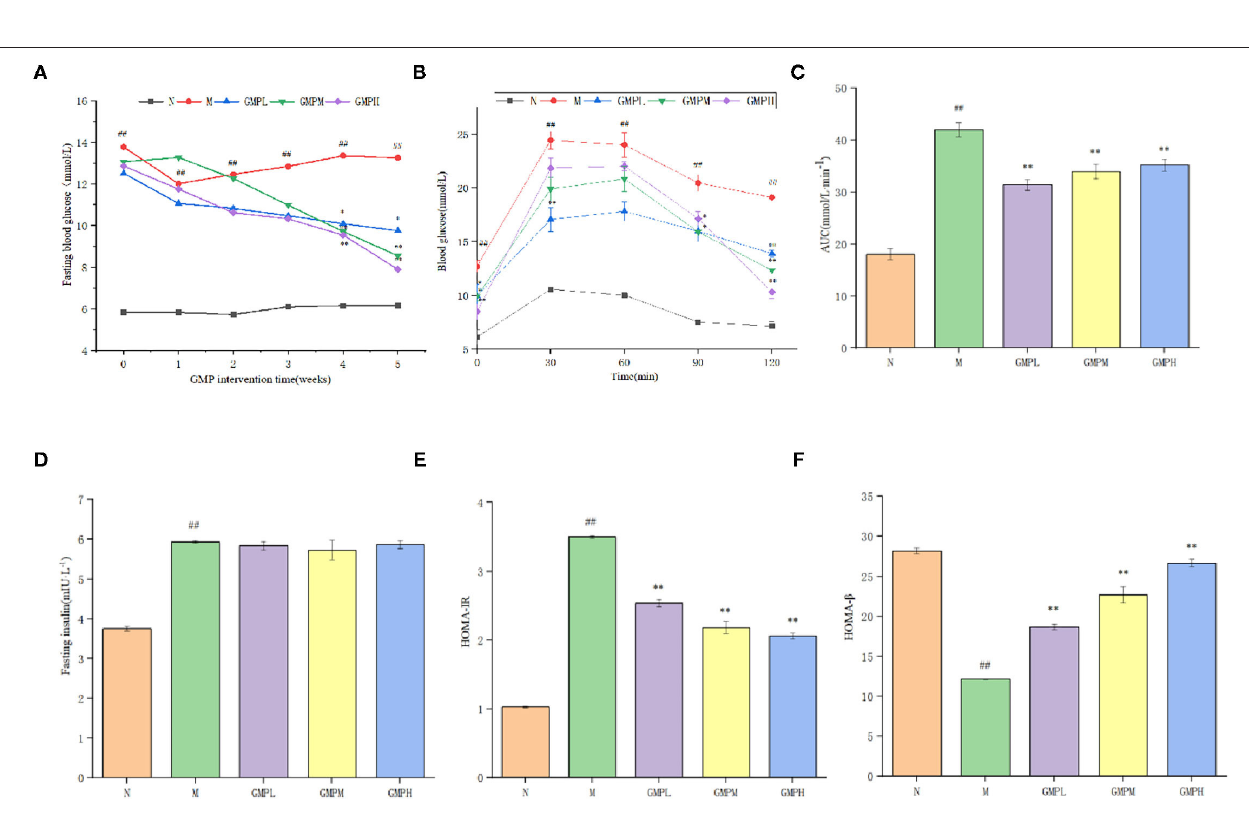
Frontiers in Nutrition |